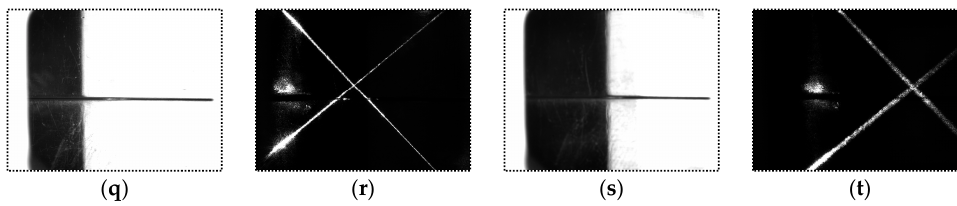
Figure 19. Images captured in different distances d and angles α . ( a ) USLS is on and d = 30 mm, α = 0°;